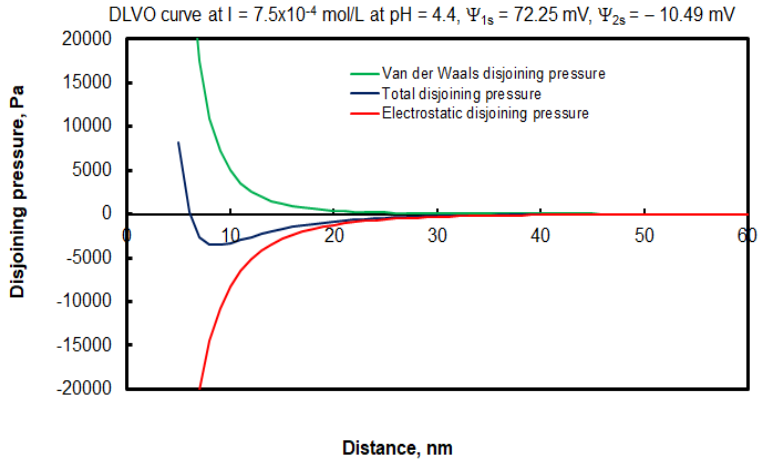
Figure 6. DLVO curves of the electrostatic, van der Waals, and total disjoining pressure of bubble approaching silica particle at ionic strength I = 7.5 × 10 − 4 mol/L.